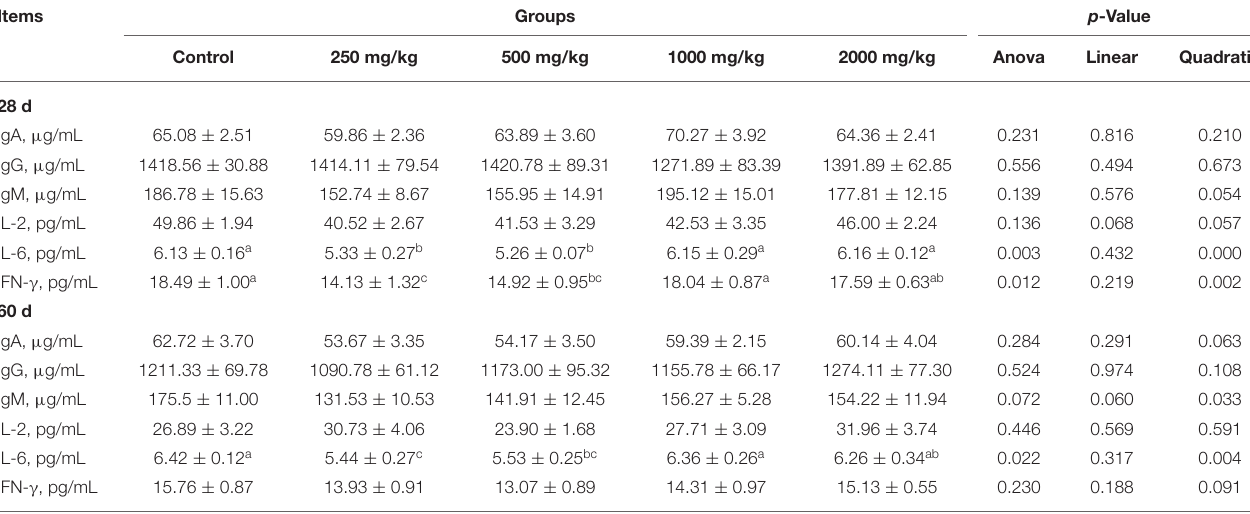
TABLE 6 | Effect of dietary Galla chinensis extract (GCE) supplementation at different levels on serum immune indexes of broilers. Items